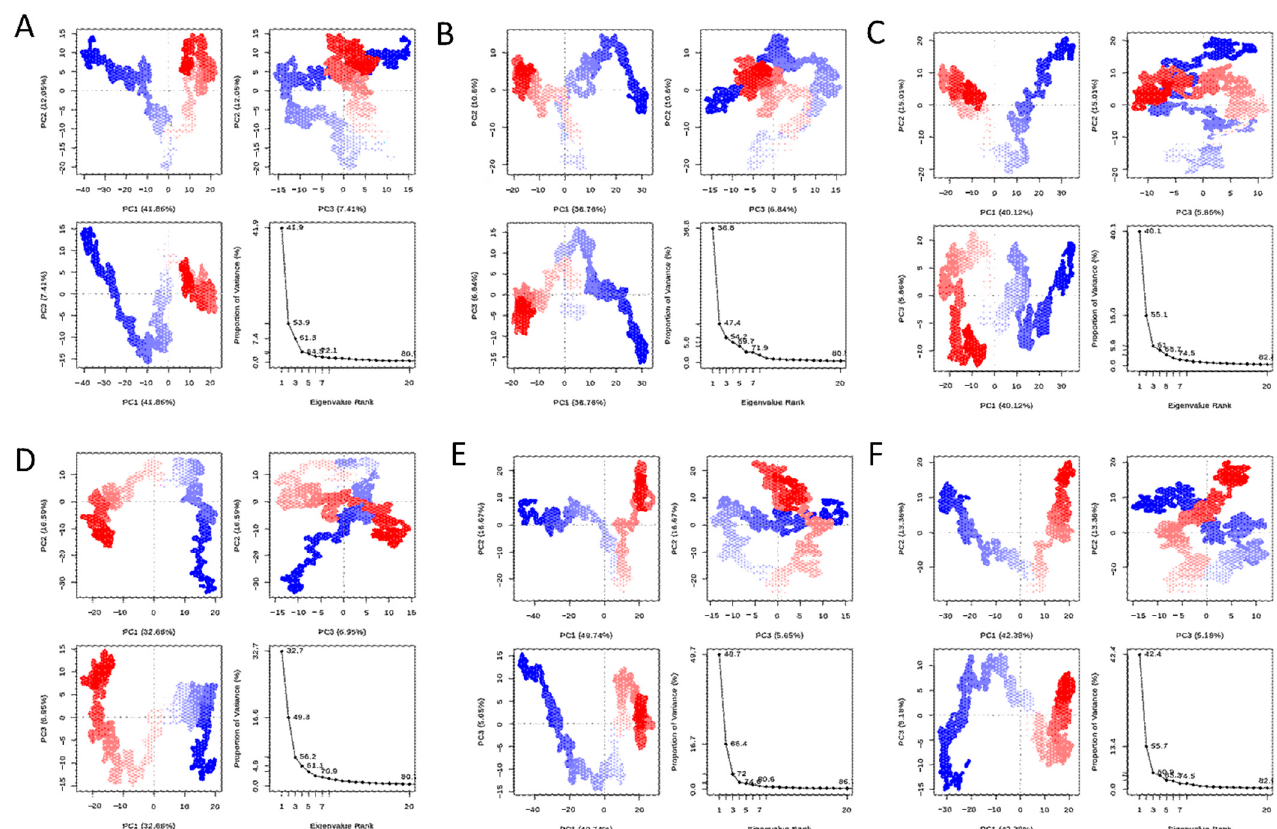
Figure 3. PCA plots of the protein backbone in the complex, comprising graphs of PC2 vs PC1, PC2